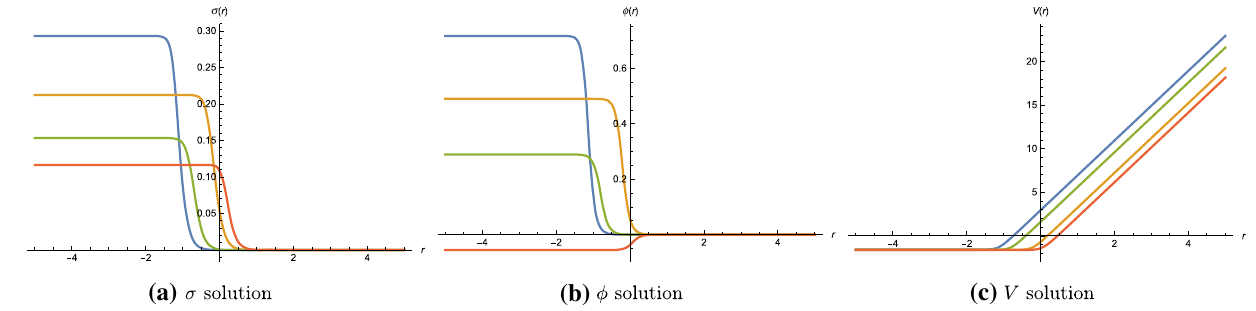
Fig. 10 RG flows from SO ( 4 ) N = ( 1 , 0 ) SCFT in six dimensions to two-dimensional N = ( 2 , 0 ) SCFT with SO ( 2 ) × SO ( 2 ) symmetry dual to AdS 3 × CH 2 solution. The blue, orange, green and red curves refer to p 2 = − 1